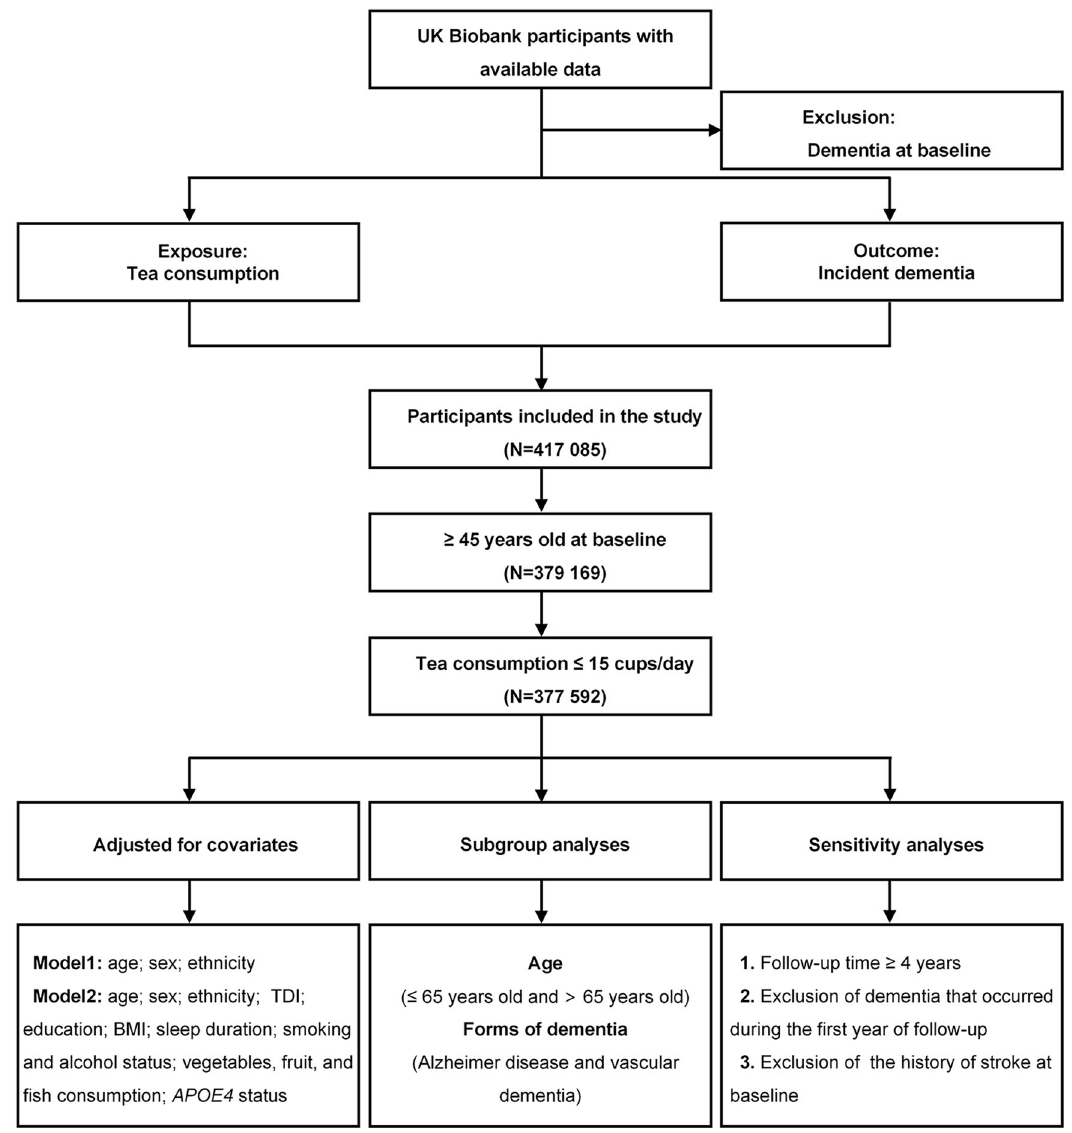
Fig. 1 Flowchart of participant selection. TDI Townsend deprivation index, BMI Body mass index, APOE4 apolipoprotein E4